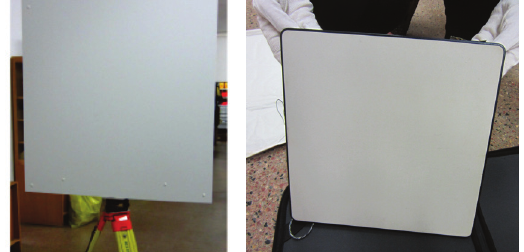
Figure 3. Standard target (left); Spectralon® target